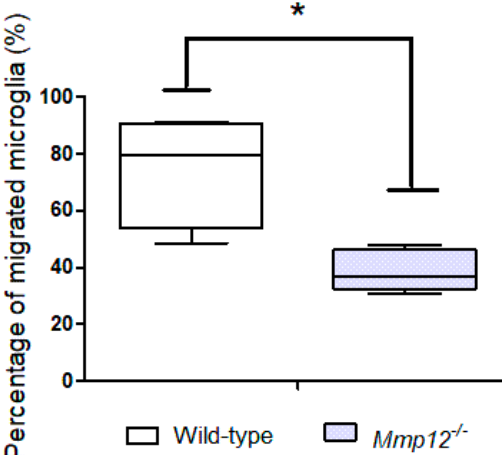
Figure 3. Microglia migration assay revealed a reduced percentage of migrated Mmp12 − / − compared with wild-type microglia cells, indicating an impact of MMP12 on microglia migration capacity. Data are shown as box plots with whiskers indicating minimum and maximum percentage of migrated microglia cells at 6 h postseeding—the lower boundary of the boxes represents the 25th percentile, the upper boundary the 75th; the horizontal line in the boxes represents the median value. Significant differences between groups detected by the Mann–Whitney U test are indicated by asterisks (* p < 0.05).